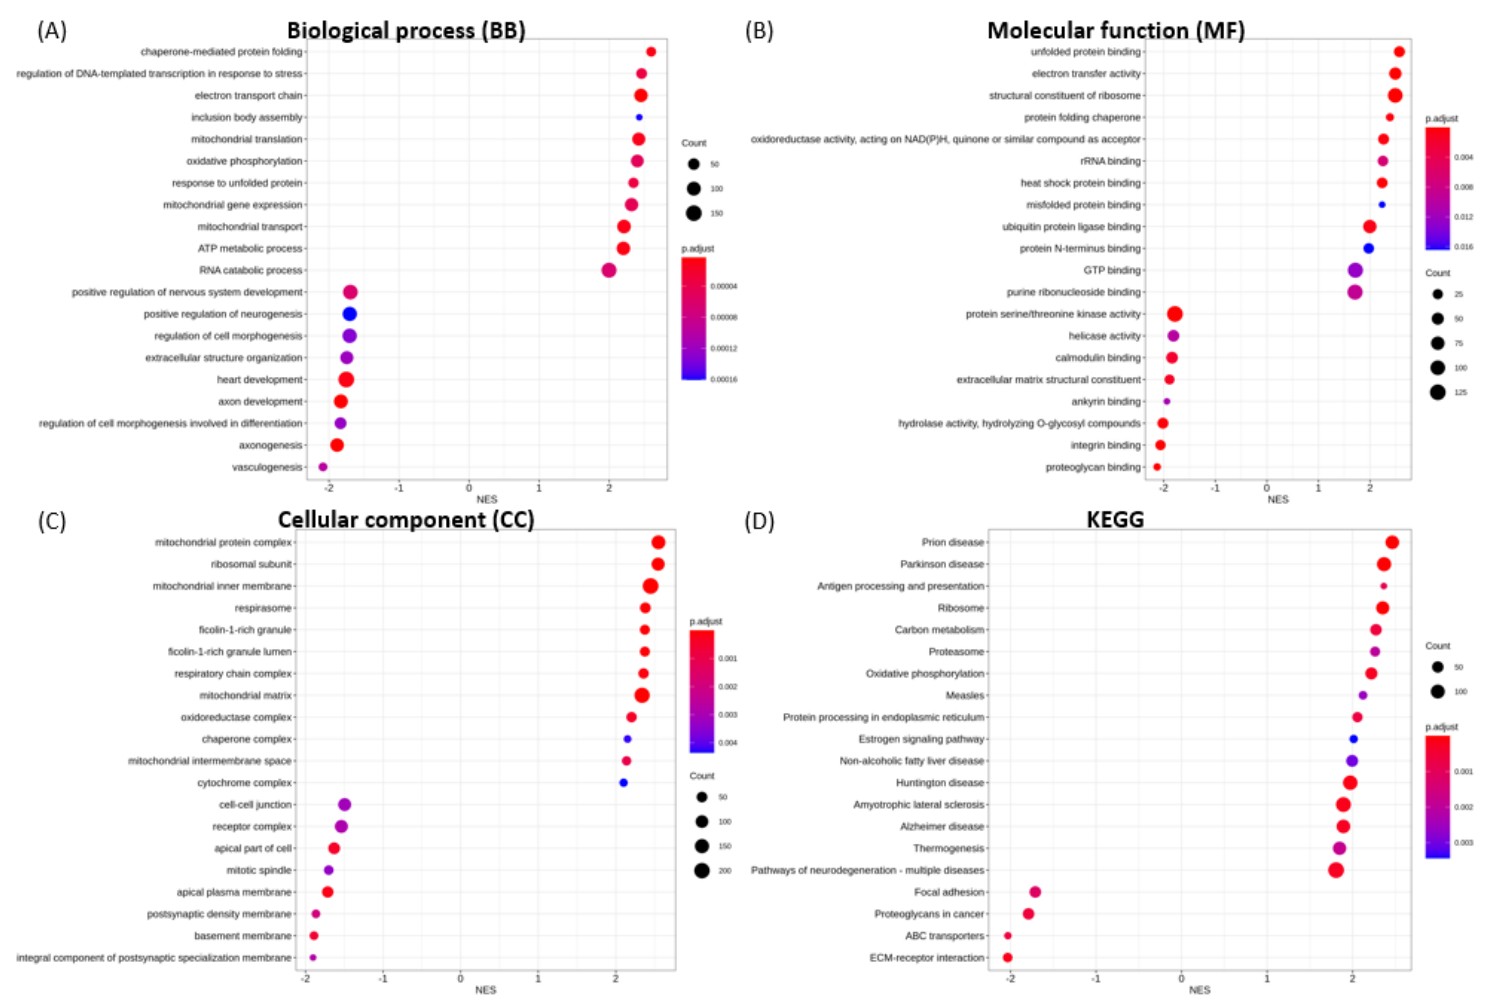
Figure 8. GSEA enrichment for SARS-CoV-2 NP transfection illustrating the top 20 most significantly enriched terms for ( A ) BP, ( B ) MF, ( C ) CC and ( D ) KEGG pathways, in decreasing order based on normalized enrichment score (NES). The transcriptional changes in S1-transfected cells were shown to enrich for BP terms associated with topologically incorrect protein and endoplasmic reticulum (ER) stress (Figure 4A), MF terms including misfolded protein binding, virus receptor activity and heat shock protein binding (Figure 4B), and blood microparticle in the CC category (Fig- ure 4C), in an up-regulated fashion. The most significantly enriched and down-regulated BP, MF and CC terms were: cell cycle G2/M phase transition, viral gene expression, ncRNA metabolic process, translational initiation (Figure 4A); structural constituent of ribosome, single-stranded DNA binding, rRNA binding (Figure 4B); and ribosomal sub- unit, chromosomal region, and mitochondrial protein complex (Figure 4C), respectively. For spike S2, the enriched GO annotations for the most significantly up-regulated gene sets include entry into host, regulation of transcription from RNA polymerase II pro- moter in response to stress, interleukin-8 (IL-8) production (Figure 5A), heat shock protein binding, unfolded protein binding, virus receptor activity (Figure 5B), blood microparti- cle, ficolin-1-rich granule, and centriole (Figure 5C). The enrichment for down-regulated gene sets are the regulation of interferon-gamma-mediated signaling pathway, regulation of phosphatidylinositol 3-kinase (PI3-kinase) activity (Figure 5A), PI3-kinase regulator ac- tivity, histone-lysine N-methyltransferase activity, protein phosphorylated amino acid binding (Figure 5B), and PI3-kinase complex (Figure 5C). GSEA also indicated the up- regulation of enrichment gene sets associated with the positive regulation of the response to cytokine stimulus, positive regulation of the cytokine-mediated signaling pathway, my- eloid leucocyte-mediated immunity, regulation of ER stress-induced intrinsic apoptotic signaling pathway, and regulation of nucleotide-binding oligomerization domain-con- taining signaling pathway (Figure 5A).